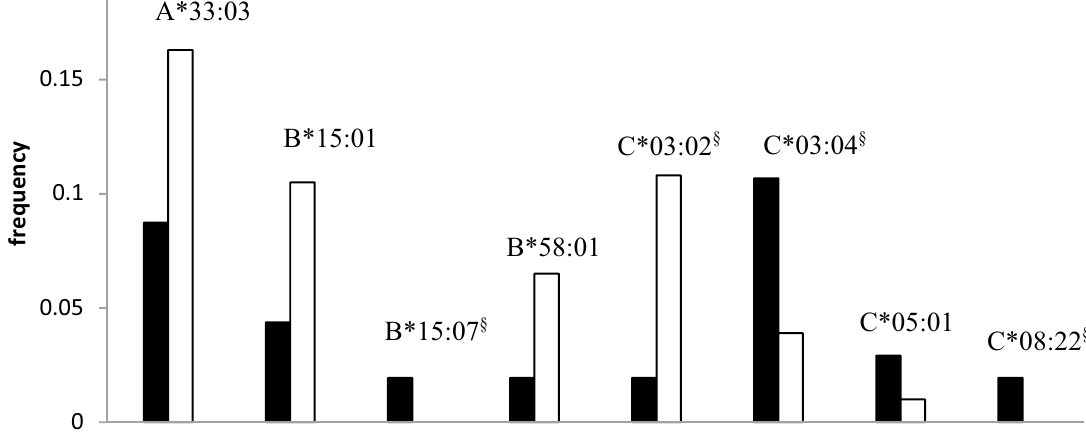
Figure 1. Frequencies of HLA class I alleles associated with sarcoidosis in Koreans. Patients—black columns, Control population—white columns. § Significant p corr .